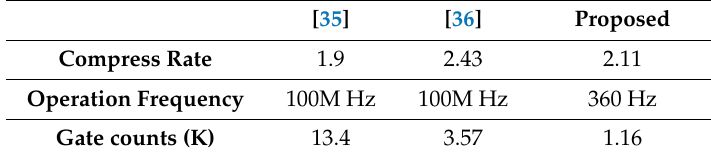
Figure 13. FPGA implementation. Table 5. Compression operation clock.